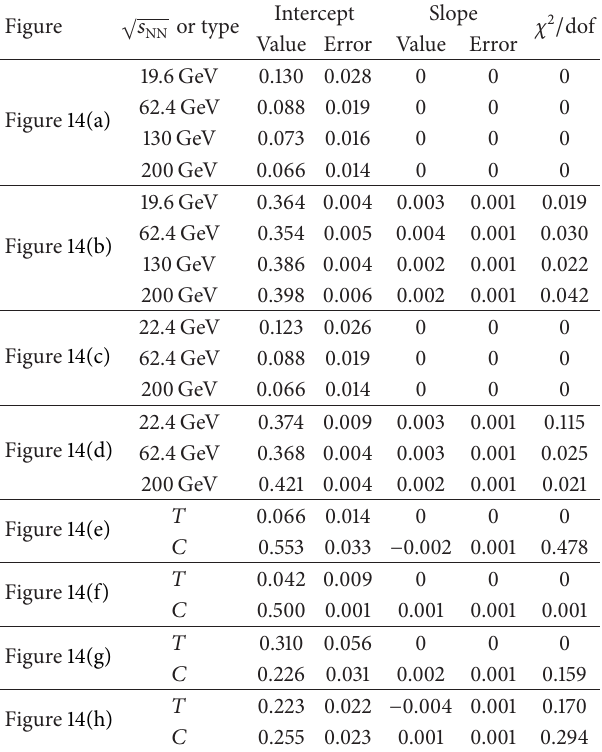
Table 9: Values of intercept, slope, and 𝜒 2 / dof for the linear relations 𝑐 2 𝑠 - 𝐶 in Figures 14(a)–14(g) and for the linear relations √𝑠 𝑐 2 in Figure 𝑠 - NN